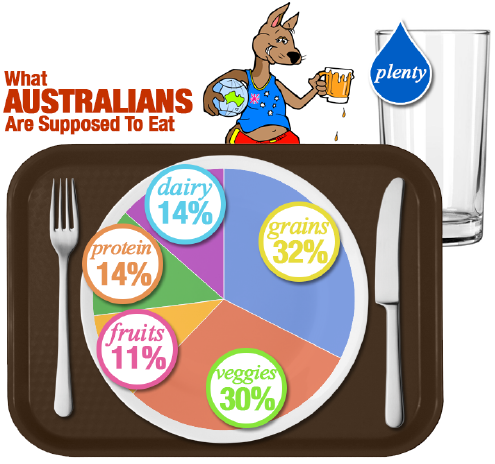
Figure 8. The Australian food guide.